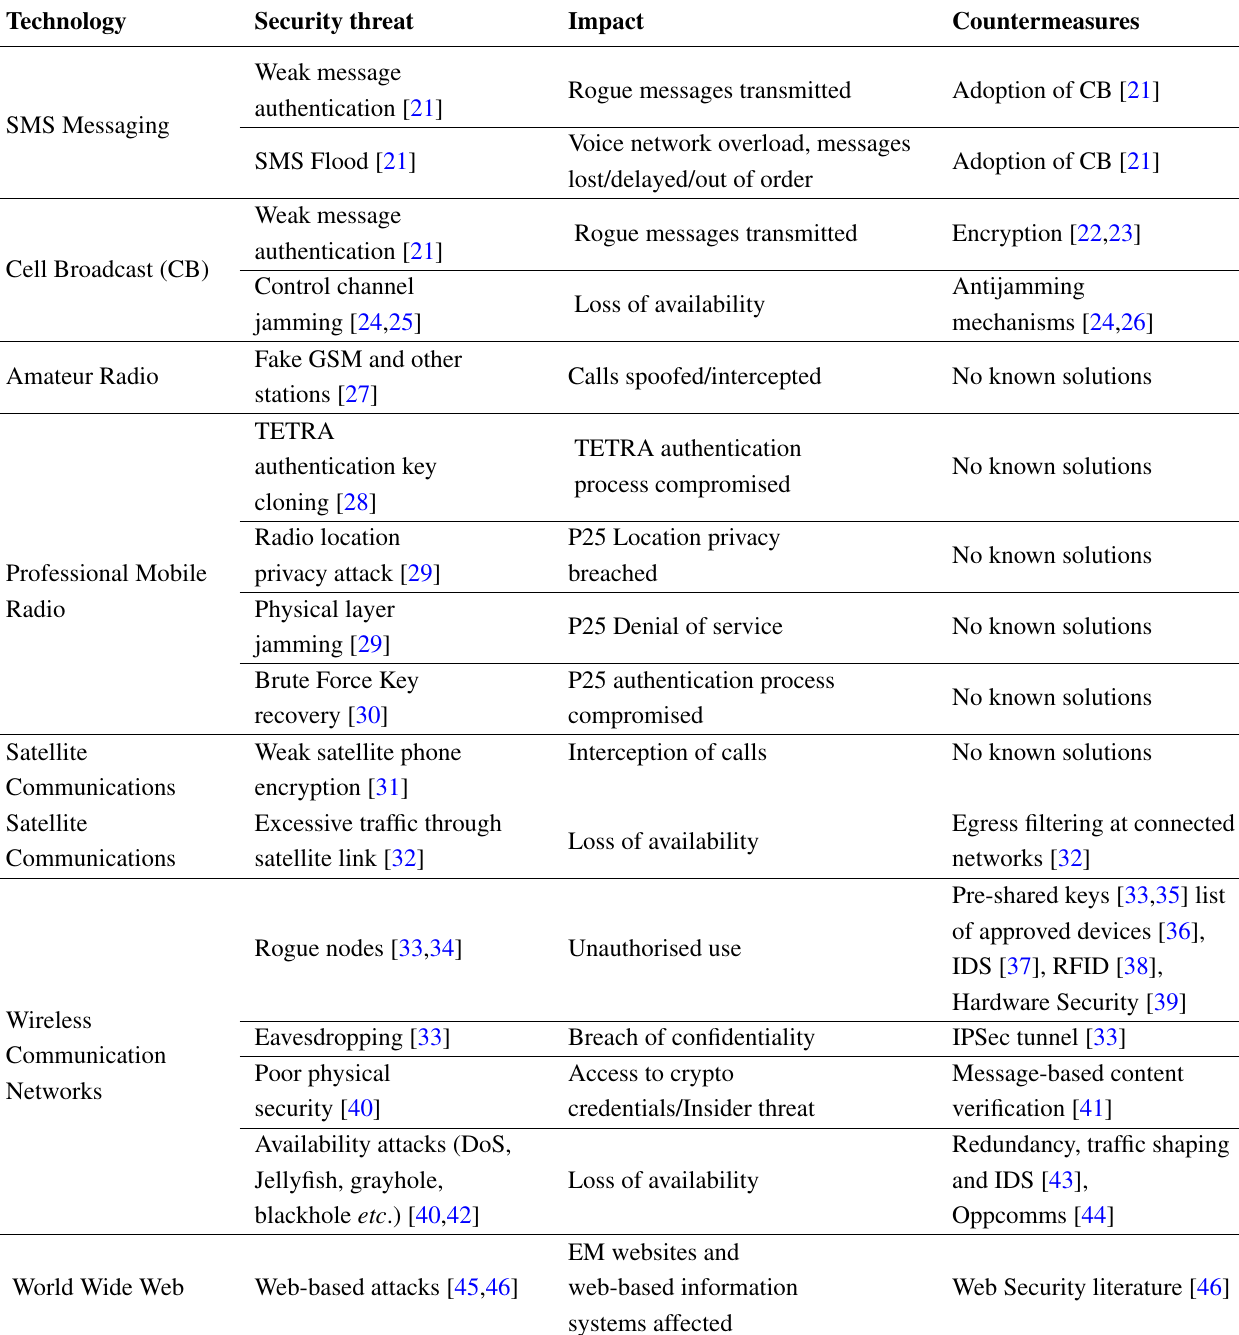
Table 1. Communication security threats and proposed EM